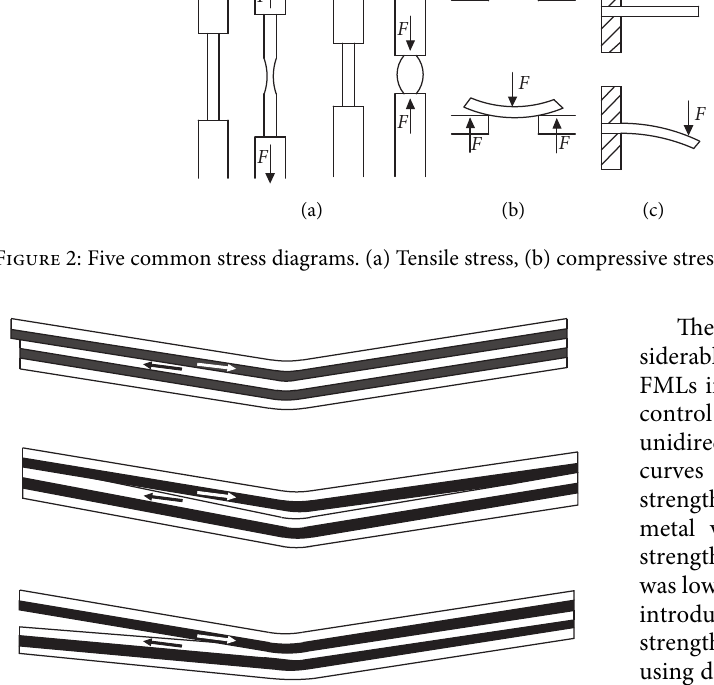
Figure 3: Failure of FMLs under pure shear stress